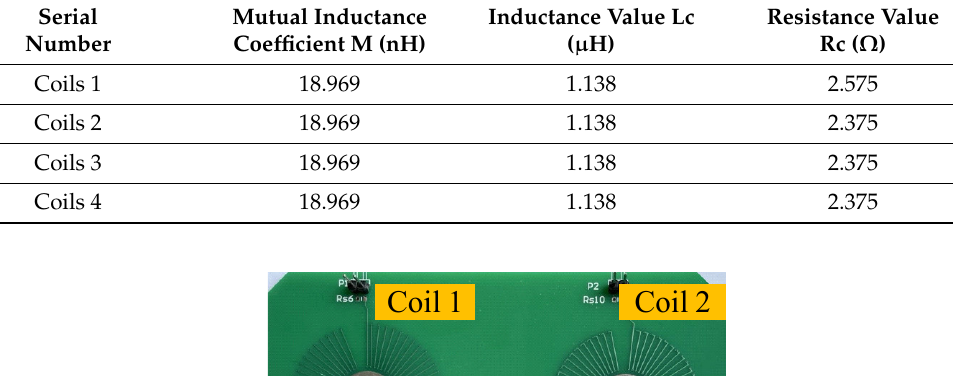
Table 2. Electrical parameters of coils 1–4.